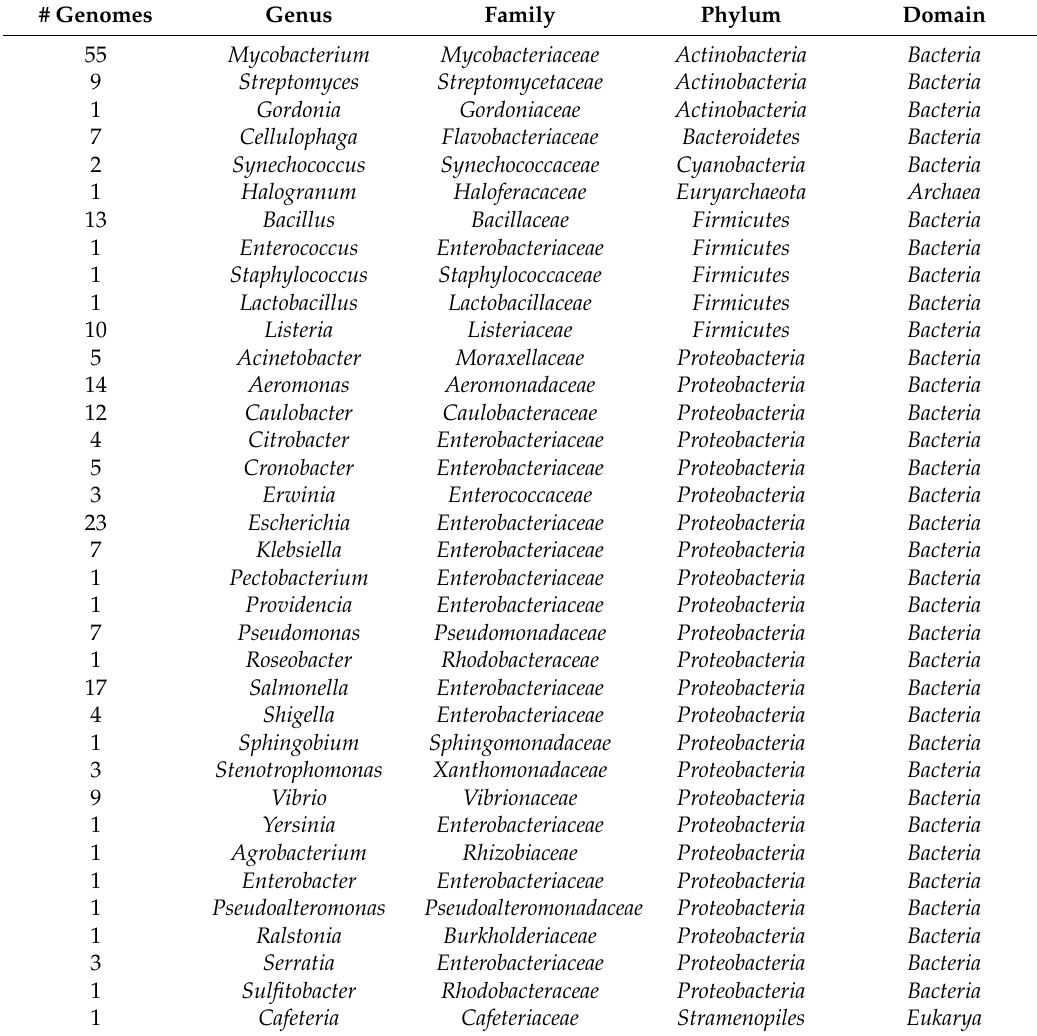
Table 2. Taxonomic information of the hosts of viruses harboring tRNA gene